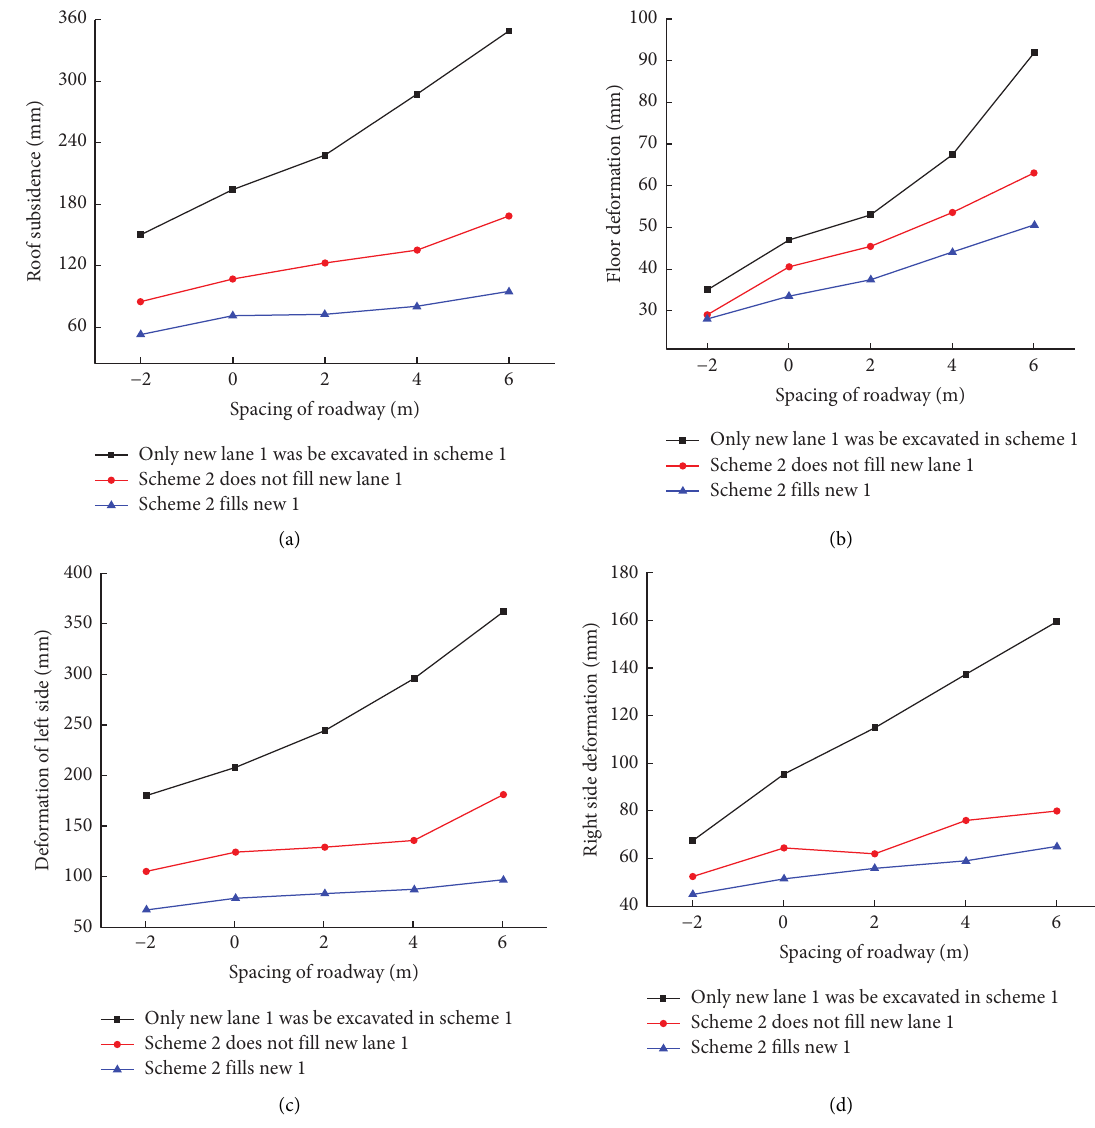
Figure 12: Deformation of the roadway under different layouts of the return air roadway. (a) Roof deflection. (b) Floor deflection. (c) Deformation of the left side. (d) Deformation of the right